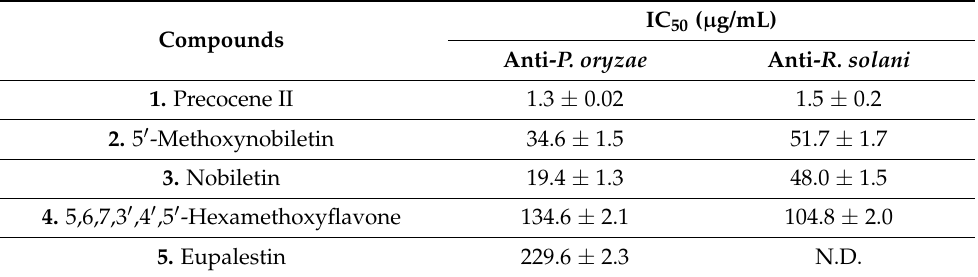
Table 1. Antifungal activities against P. oryzae and R. solani of compounds 1 – 5 . Based on the results shown in Figures 4 and 5, IC 50 values were calculated and expressed as mean ± SE. N.D. indicates that activity was not detected in the range of 10–250 µ g/mL. Figure 5. Antifungal activities of isolated compounds 1 – 5 ( A – D ) against the development of R. IC 50 ( µ g/mL) solani . R. solani was cultured for 1 day on PDA plates containing different concentrations of each Compounds Anti- P. oryzae Anti- R. solani compound from 10 to 250 µg/mL . Then, the diameters of mycelial growth area of fungi were meas- ured and IC 50 values were calculated. PI (%) calculated was plotted vs logarithmic concentration of the compound. n = 3. 4. 5,6,7,3 (cid:48) ,4 (cid:48) ,5 (cid:48) -Hexamethoxyflavone 229.6 ± 2.3 N.D. 3.5. Field Trial Test for Protective Effect of ACE on Rice Crop against P. oryzae Infection To assay the effect of ACE on the infection of rice with P. oryzae in a shaded net- house, we sprayed 0.2% DMSO (negative control), ACE, or tricyclazole (commercially available fungicide, positive control) at 2 days after inoculation with P. oryzae . The negative control (Figure 6A) showed distinct symptoms of blast disease after treatment for 15 days, while rice plants sprayed with ACE (Figure 6B) or tricyclazole (Figure 6C) showed fewer symptoms and seemed to be healthier. At 5, 10, and 15 days of treatment, the disease indices (%) of the ACE-treatment and tricyclazole groups were significantly smaller than those of the negative control group (Figure 6D). Compared with the negative control, at 10 and 15 days after treatment, 2 mg/mL of ACE suppressed the infection by 57.1% and 55.5%, and 0.625 mg/mL of tricyclazole suppressed the infection by 64.1% and 63.8%, respectively. These effects of ACE and tricyclazole treatments showed no significant differences, confirming the protective effect of ACE on rice from blast disease.